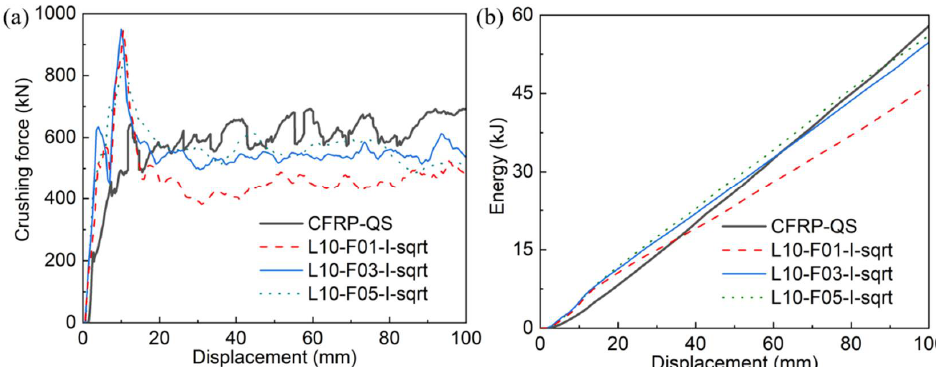
Figure 10. Comparisons of ( a ) crushing force–displacement curves and ( b ) energy–displacement curves between experimental (CFRP-QS) and simulated results with friction coefficients of 0.1, 0.3, and 0.5.